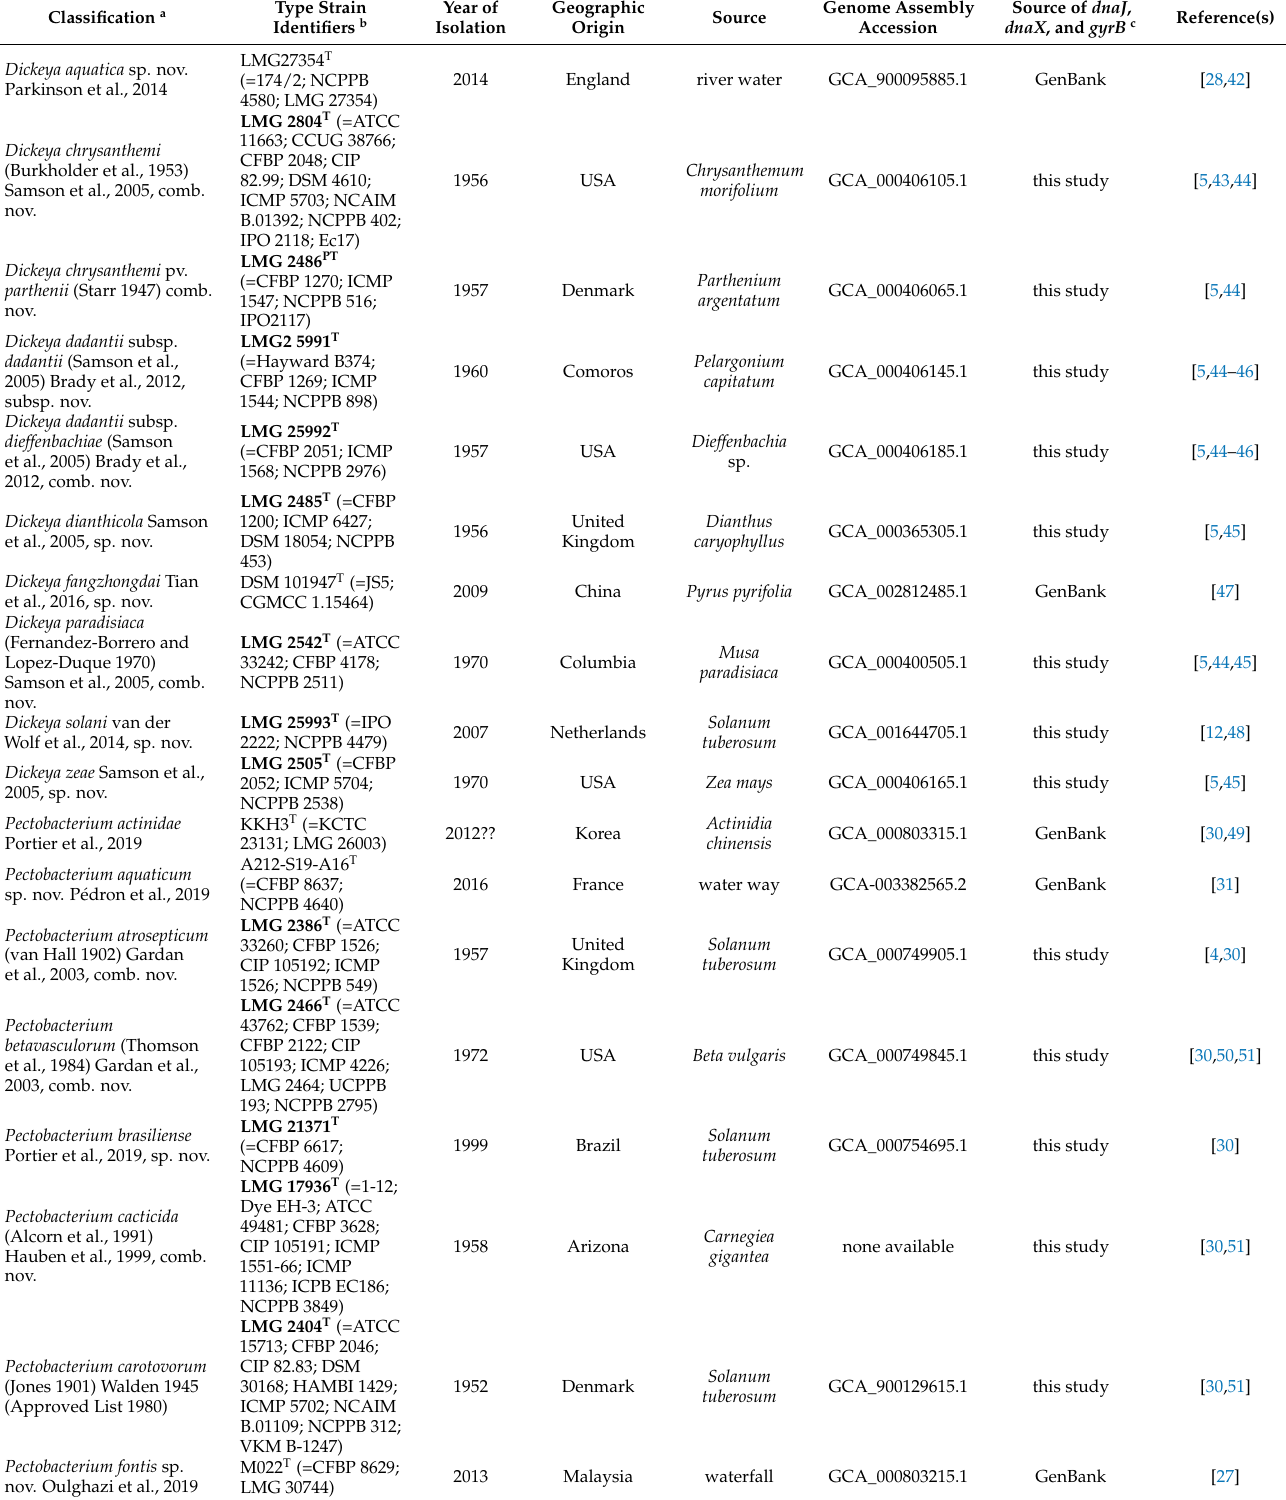
Table 2. Description of type and pathotype strains used in this